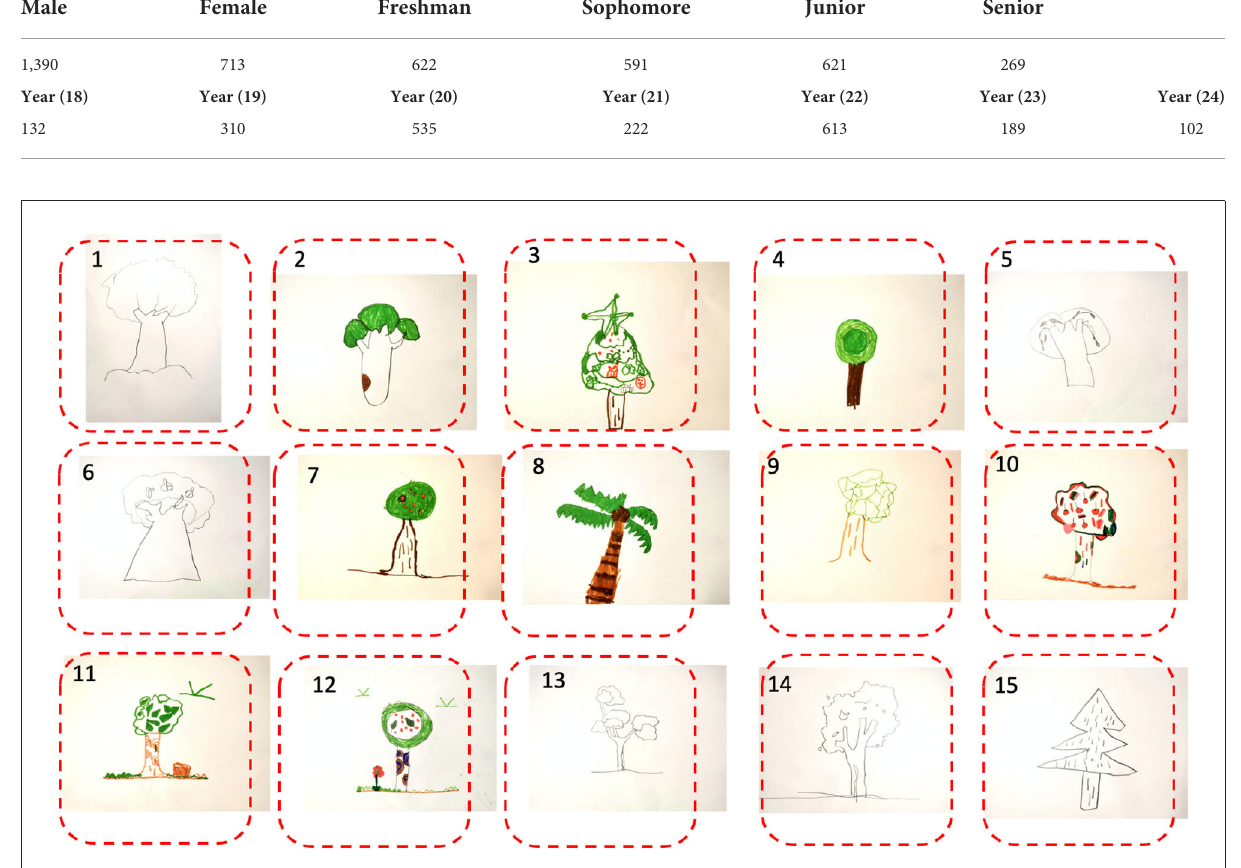
FIGURE2 A group of hand-drawn paintings with the specified theme